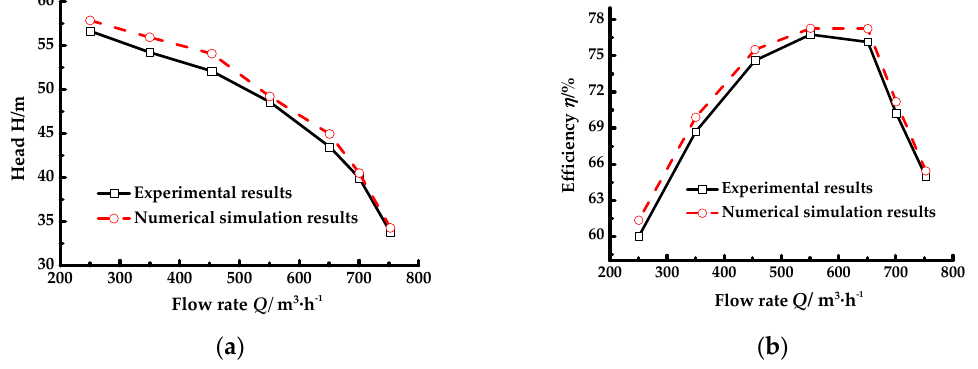
Figure 11. Comparison of the hydraulic performances of centrifugal pump. ( a ) Head ( H )-flow rate ( Q ). ( b ) Efficiency ( η )-flow rate ( Q ).